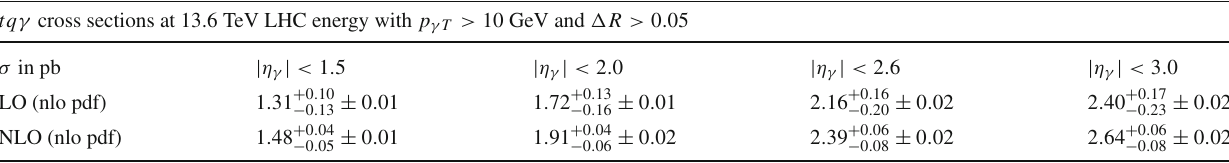
√ S = 13 . 6 TeV, with m t = 172 . 5 GeV and MSHT20 NLO pdf